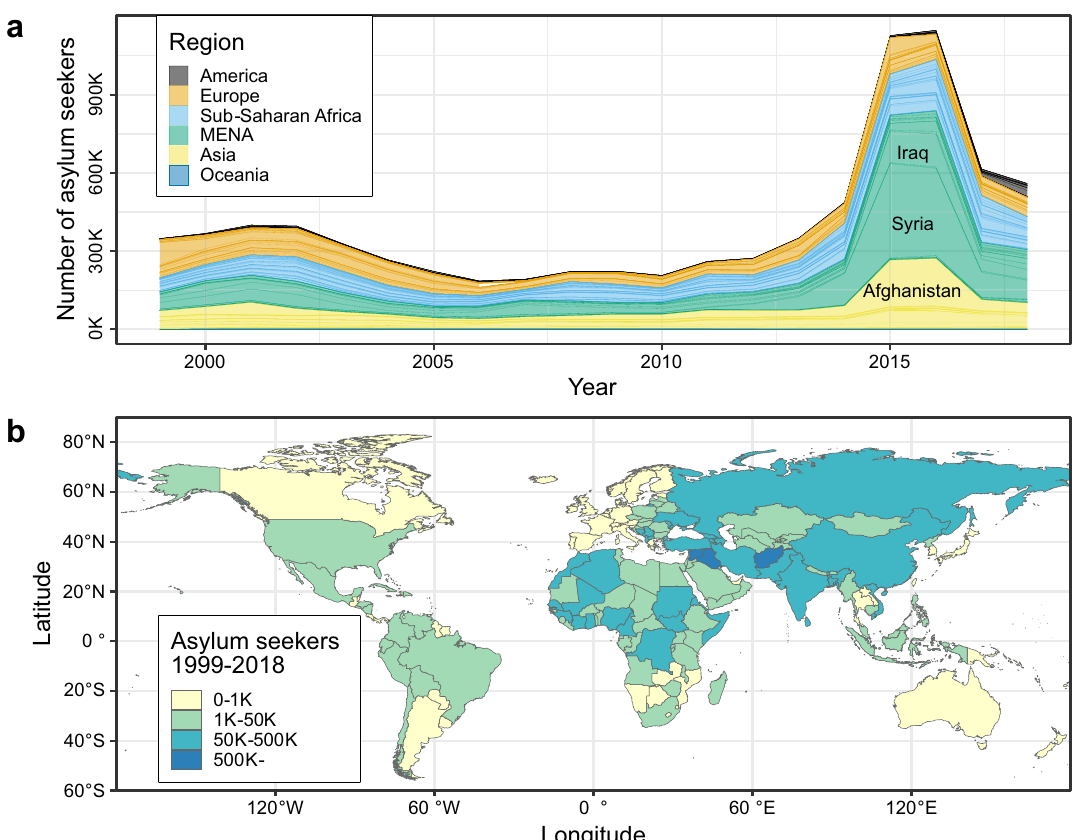
Fig. 1 Spatiotemporal patterns of asylum migration to the EU. a Trend in annual number of new asylum applications by country and region of origin, 1999 – 2018. MENA is the Middle East and North Africa. b Total volume of fi rst-time asylum applications submitted to the EU by country of origin, 1999 –